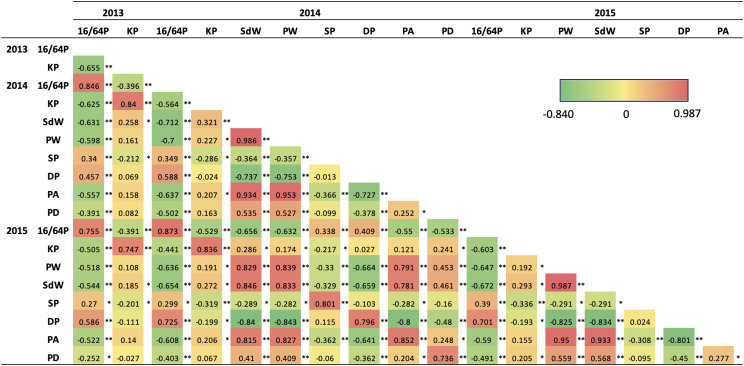
Pearson correlations for the seed and pod traits evaluated over three years. Red for the highest value and dark green for lowest value on the heatmap scale. Significant correlations * P < 0.05 and ** P < 0.001. 16/64P, 16/64 percentage as seed size index; KP, kernel percentage; PW, pod weight; SdW, seed weight; SP, single-kernel pods; DP, double-kernel pods; PA, pod area; PD, pod density.